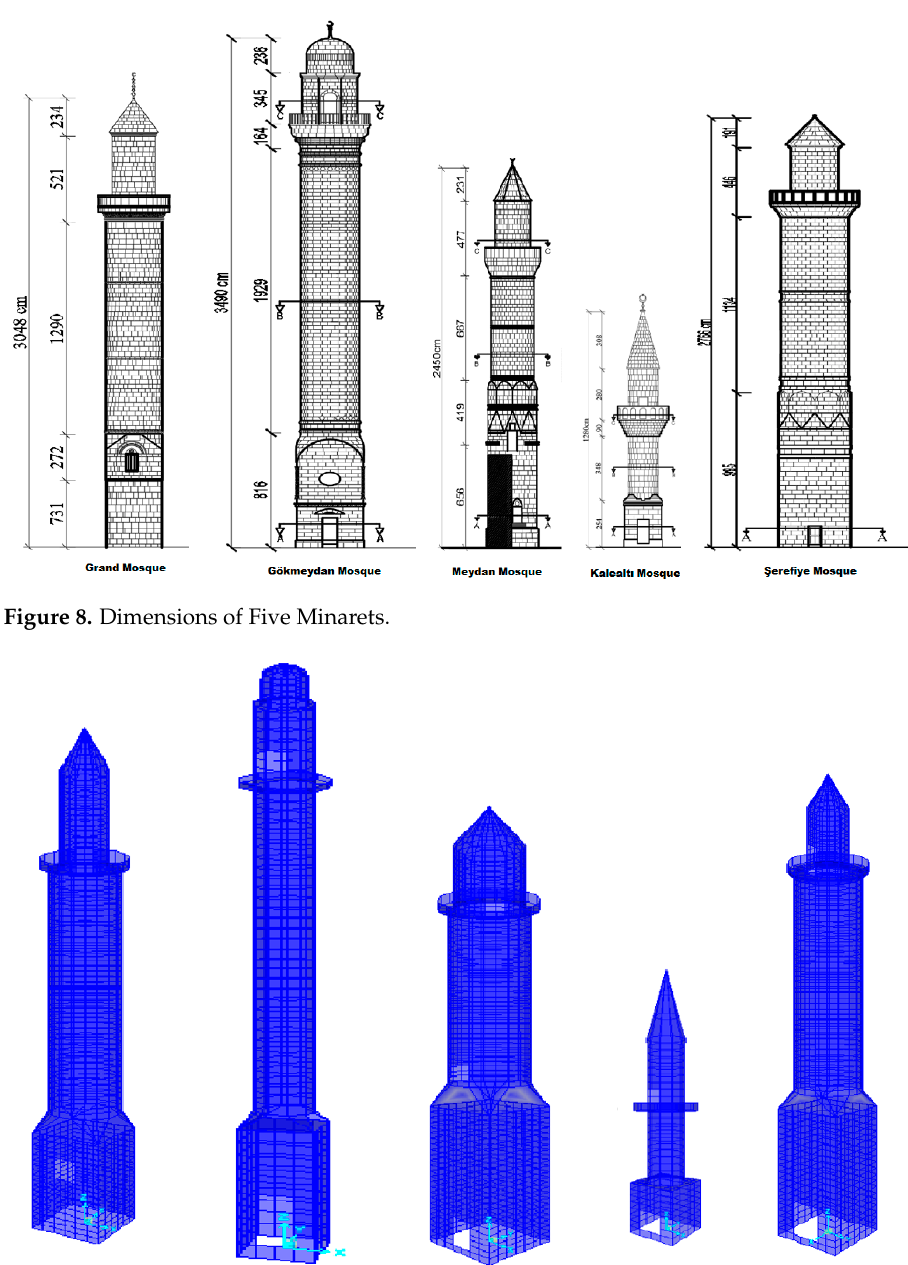
Figure 9. Three-dimensional models obtained from the software program of Five Minarets.